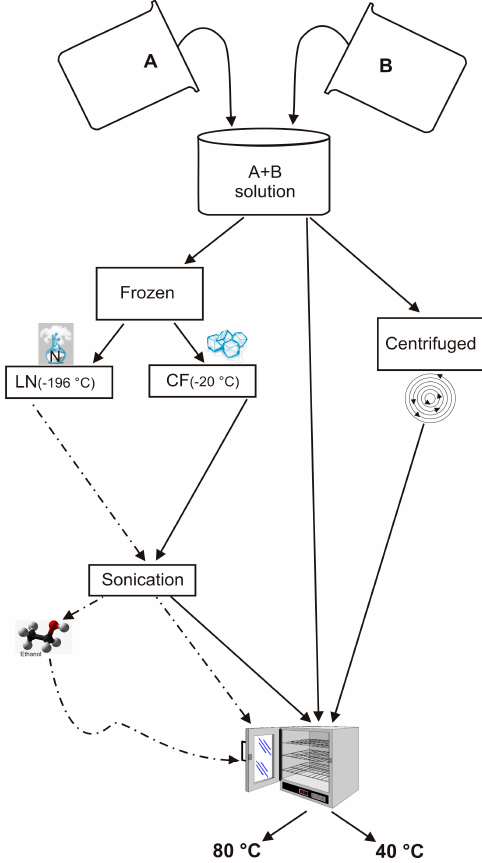
Figure 1. Schematic presentation of the experiments performed.